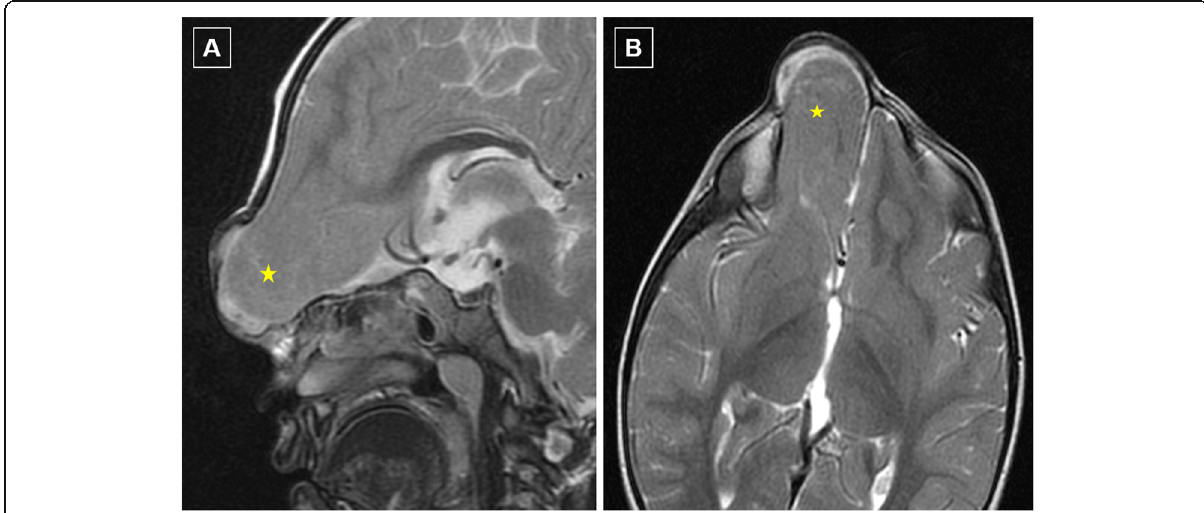
Fig. 2 Paramedian frontal encephalocele. ( a ) (T2-weighted sagittal) and ( b ) (T2-weighted axial) images show herniation of dysplastic brain (star) through the frontal bone on the right side. The herniated content is located in a paramedian location which is an unusual position for the sincipital encephalocele